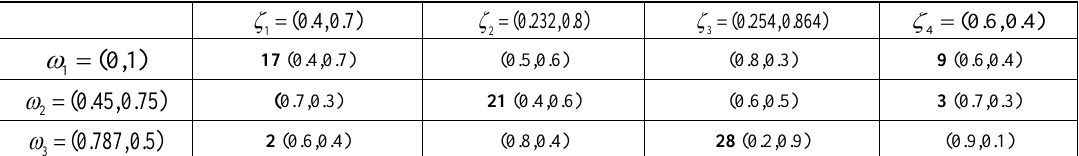
Table 4. Second table for finding opportunity